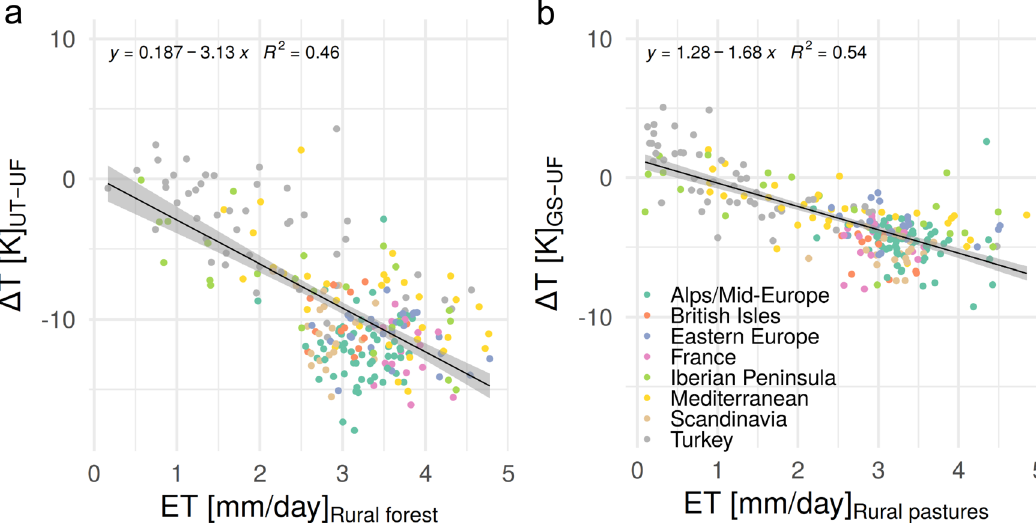
Fig. 4 Mean summertime temperature differences ( Δ T ) between urban vegetated areas and continuous urban fabric plotted against evapotranspiration of vegetated areas outside of each city. a Scatterplot of temperature differences between urban trees (UT) and urban fabric (UF) plotted against evapotranspiration (ET) estimated for rural forests. b Scatterplot of temperature differences between treeless urban green spaces (GS) and urban fabric (UF) plotted against evapotranspiration estimated for rural pastures. Each dot represents a city. All cities in a speci fi c region have the same